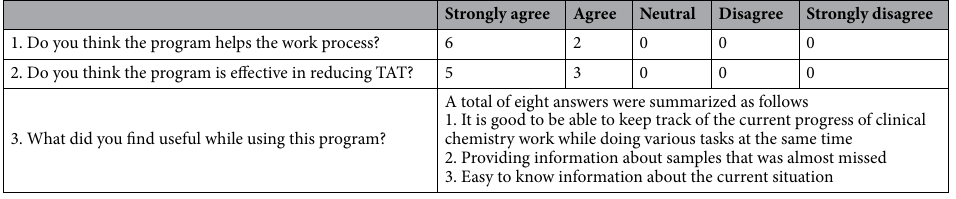
Table 2. Results of the survey on the program’s